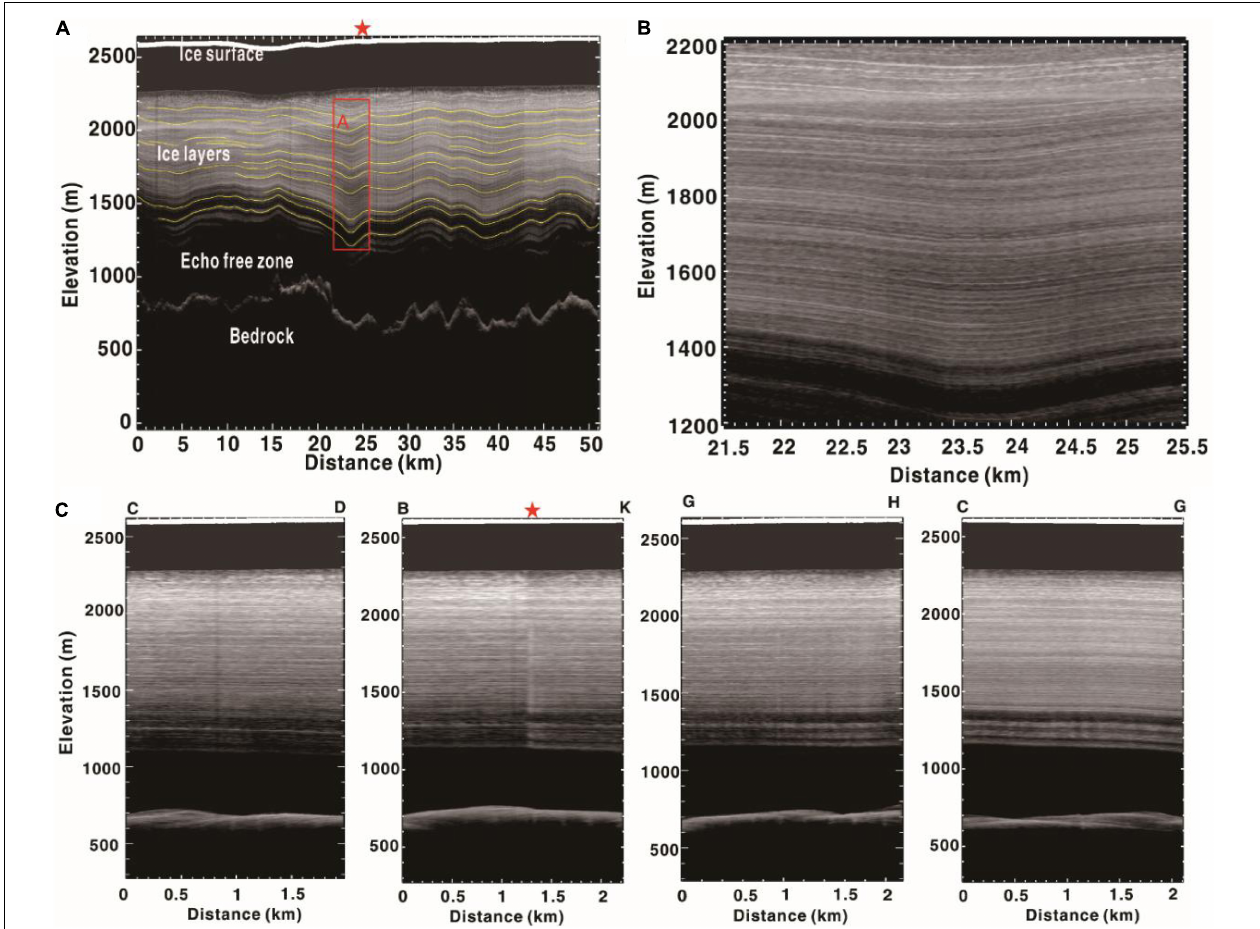
FIGURE 4 | Radargrams of ice-penetrating radar from CHINARE (Chinese Antarctic Research Expedition) 29. The red star marks the position of Taishan Station. (A) Profile of high resolution (150 MHz) corresponding to the black line though Taishan Station in Figure 3B . (B) Radar profile of the selected red rectangles in (A) . (C) Radar profiles around Taishan Station (corresponding to Figure 3C